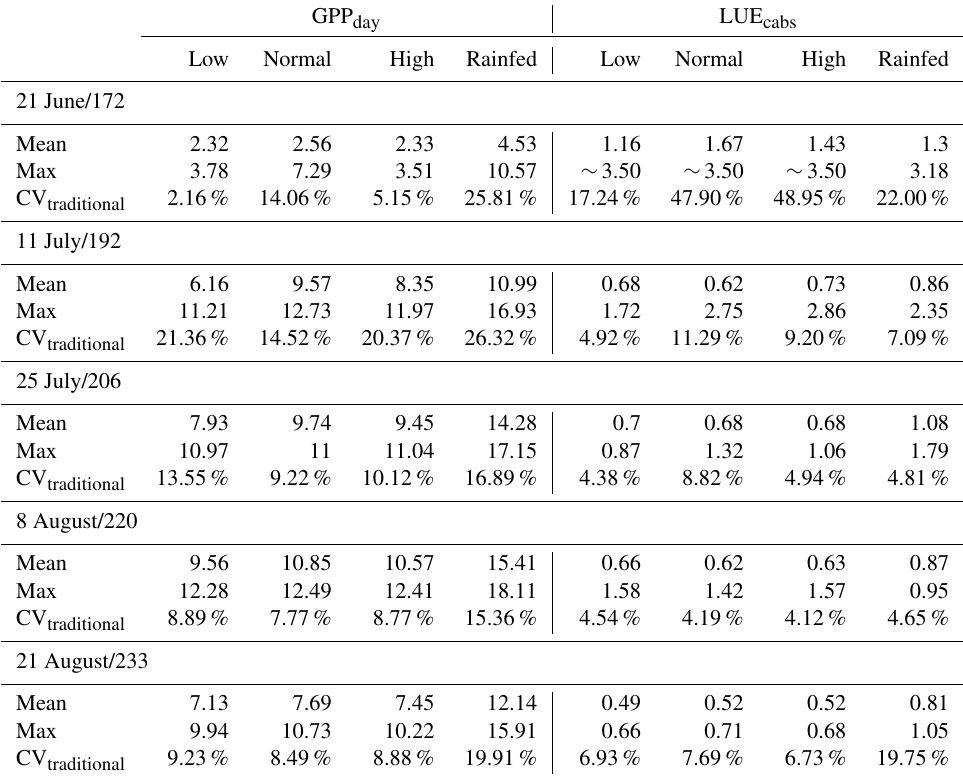
Table 2. Descriptive statistics of GPP day (g Cm − 2 d − 1 ) and LUE cabs (g CMJ − 1 ) at each nutrient treatment in the PD rice and at the